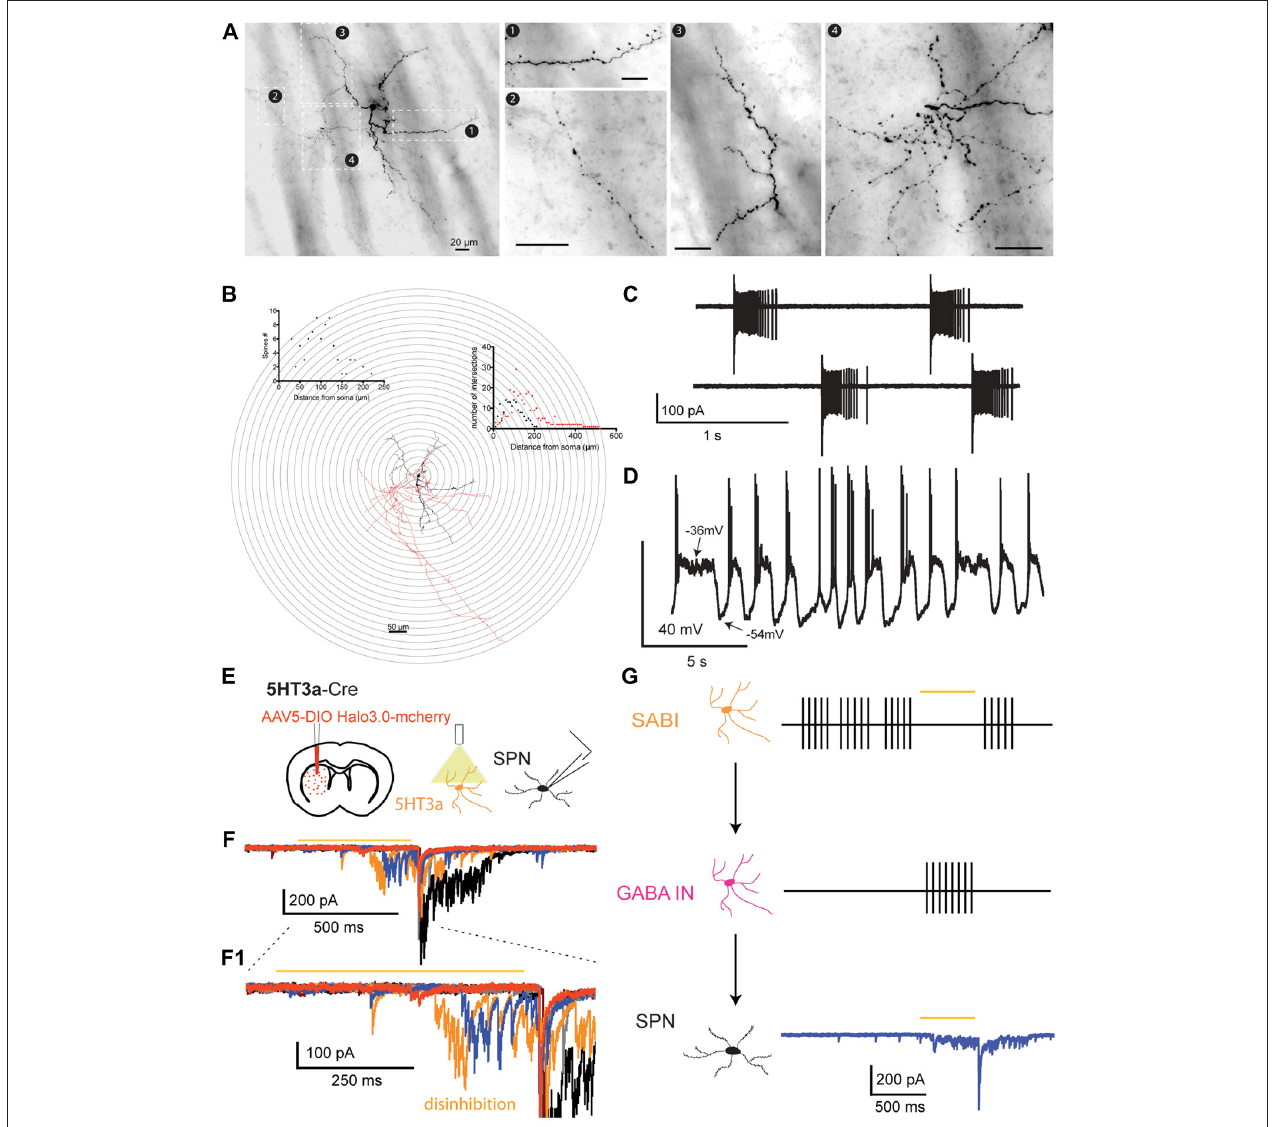
FIGURE 4 | Anatomical and physiological properties of the spontaneously active bursty interneuron (SABI) and related circuit properties. (A) Neurocytology of typical electrophysiologically identified SABI interneurons labeled with biocytin after whole cell recording. SABIs emit several primary dendrites and secondary and higher-order dendrites are sparsely invested with dendritic spines (black arrows, box 1 and box 3). The axonal arborization was relatively sparse, exhibited prominent varicosities, and comprised small dense and tortuous fields near the soma (box 4), as well as sparse extended axons that extended well beyond the dendritic arborization (box 3). Scale bar value (20 µ m) is the same for all panels. (B) 3D reconstruction and Sholl analysis of SABIs filled with biocytin after recording. The soma and dendritic fields are represented in black and the axon in red in the reconstructed image and the associated Sholl plot. (C) Representative cell-attached recordings of SABI exhibiting burst firing showing spike frequency adaptation, separated by periods of complete silence. (D) Spontaneous firing activity recorded in approximately half of SABI exhibit membrane potential fluctuations with action potential firing happening only during the beginning of the up state. (E) Schematic of the experimental paradigm. AAV5 Ef1a DIO HR3.0-EYFP was injected into the striatum of Htr3a-Cre mice and SPNs were recorded ex vivo using a cesium-based high-chloride internal solution (125 mM CsCl). (F) Representative examples of raw voltage-clamp data traces recordings in a SPN in the disinhibition protocol. Orange bar indicates the yellow light pulse. (F1) Expanded view of the disinhibitory IPSCs occurring during and immediately after the yellow light pulse. (G) Circuit diagram depicting the disinhibitory circuit hypothesized to mediate these responses. The Htr3a-Cre interneurons that are spontaneously active (i.e., the SABIs) are inhibited by halorhodopsin, which in turn disinhibits another, as yet unidentified population of interneuron(s) evoking these IPSC barrages in SPN. Figure adapted from Assous et al. (2018).